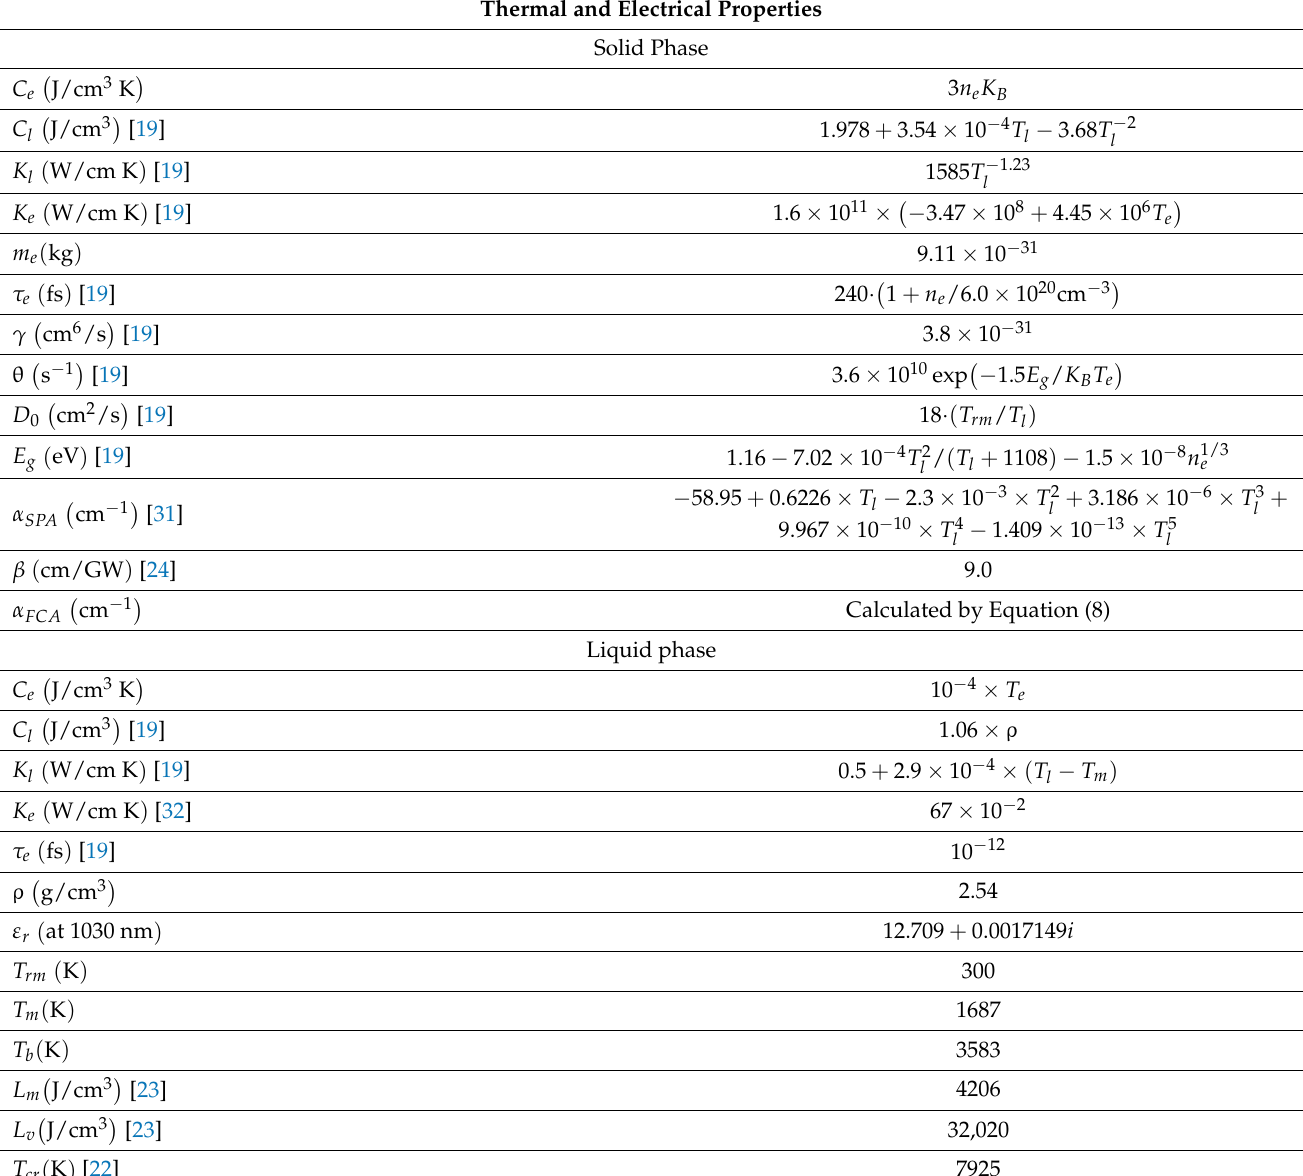
Table 1. Model parameters. Thermal and Electrical Properties Solid